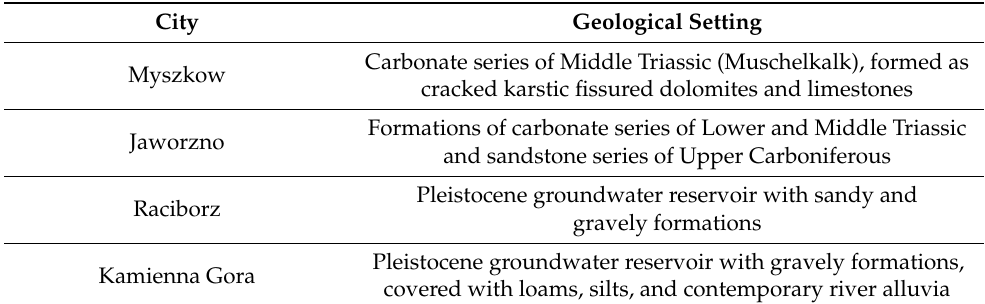
Table 1. Geological setting of groundwater used as a source of drinking water. City Geological Setting